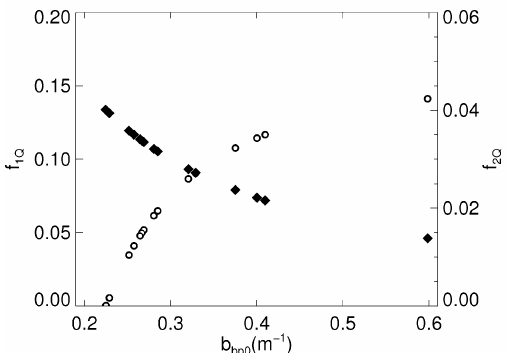
Figure 3 The correlation between the retrieved values of values b bp0 , f 1Q (closed diamonds) and f 2Q (open circles) for the 20 runs.